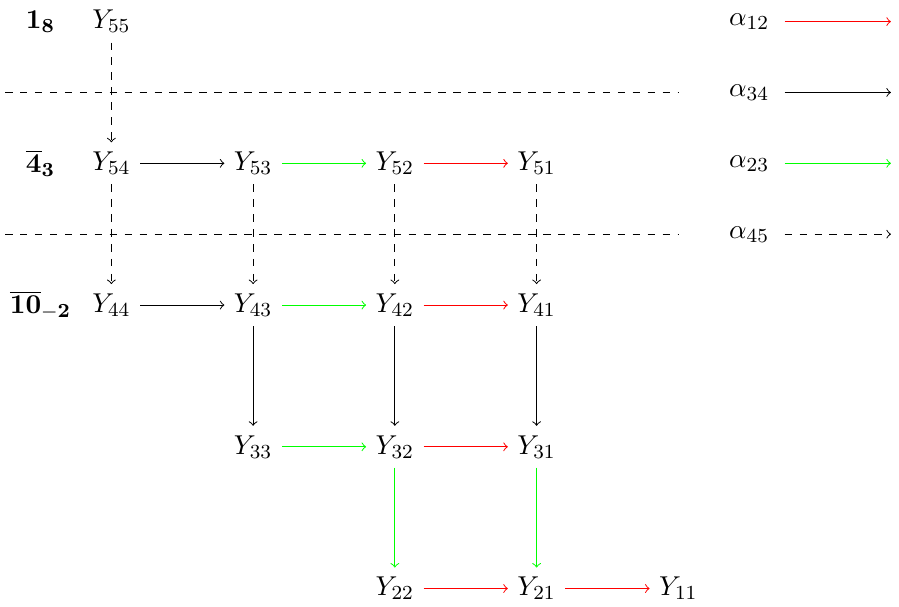
Figure 3 . Weight diagram of the 15 of sl (5) with weights arranged into irreducible representations upon decomposition SL(5) ! SL(4) (cid:2) GL(1) when the root (cid:11) 45 is deleted. The action of di(cid:11)erent roots is denoted by di(cid:11)erent colours and the direction of an arrow shows the lowering of a weight.